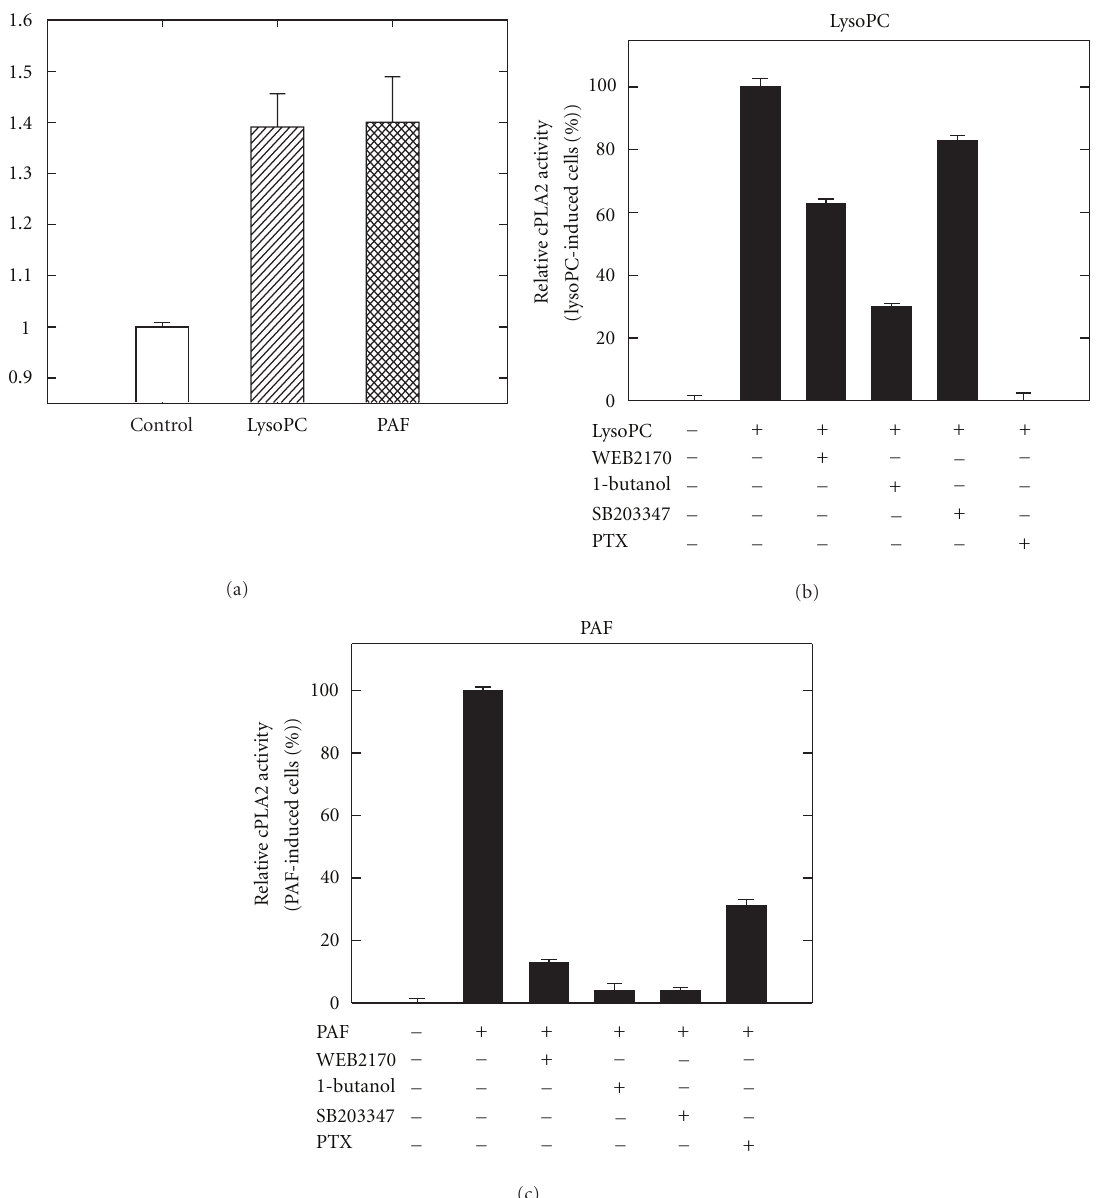
Figure 5: cPLA2 activity is di ff erentially regulated by lysoPC and PAF. (a) cPLA 2 enzyme assays were done on cell lysates treated with lysoPC or PAF. (b) and (c) cPLA 2 activity was determined in lysates from THP-1 monocytes treated with di ff erent chemical inhibitors before stimulation with (b) lysoPC or (c) PAF. Data are expressed as means ± SD of duplicate determinations within separate experiments. Data shown are one representative of three independent